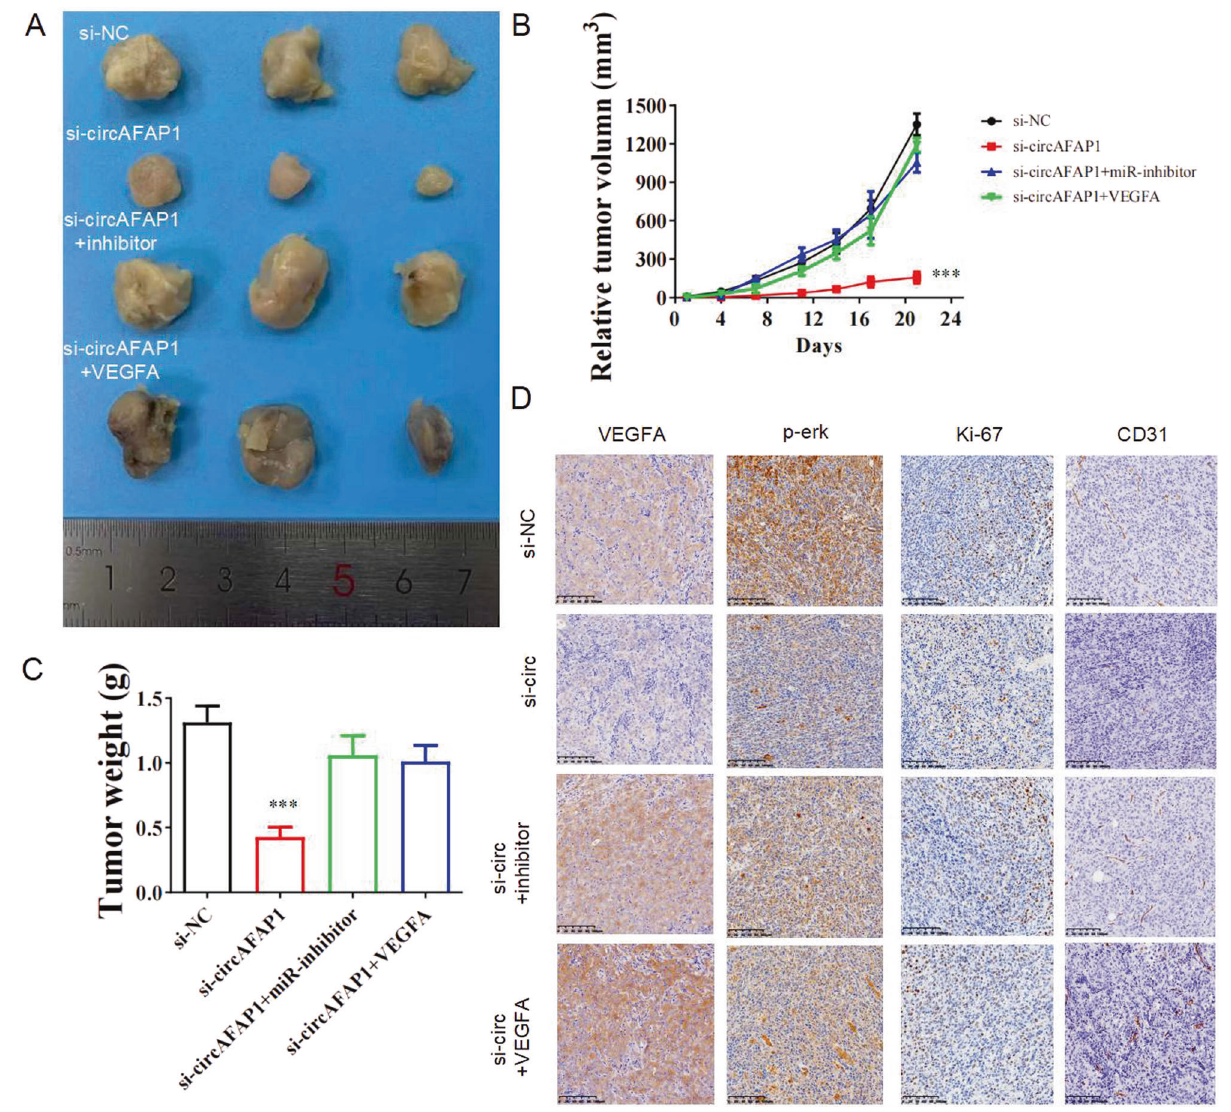
Fig. 5 Silencing circAFAP1 suppressed ccRCC growth in vivo. A Transfected 786-O cells were subcutaneously injected and sacri fi ced 21 days after injection. B , C Each of tumor volumes ( B ) and weights ( C ) was measured individually and displayed. ***represents p < 0.001. D Immunohistochemical staining displayed the expression of VEGFA, p-erk, ki-67, and CD31 in the tumor tissue of nude